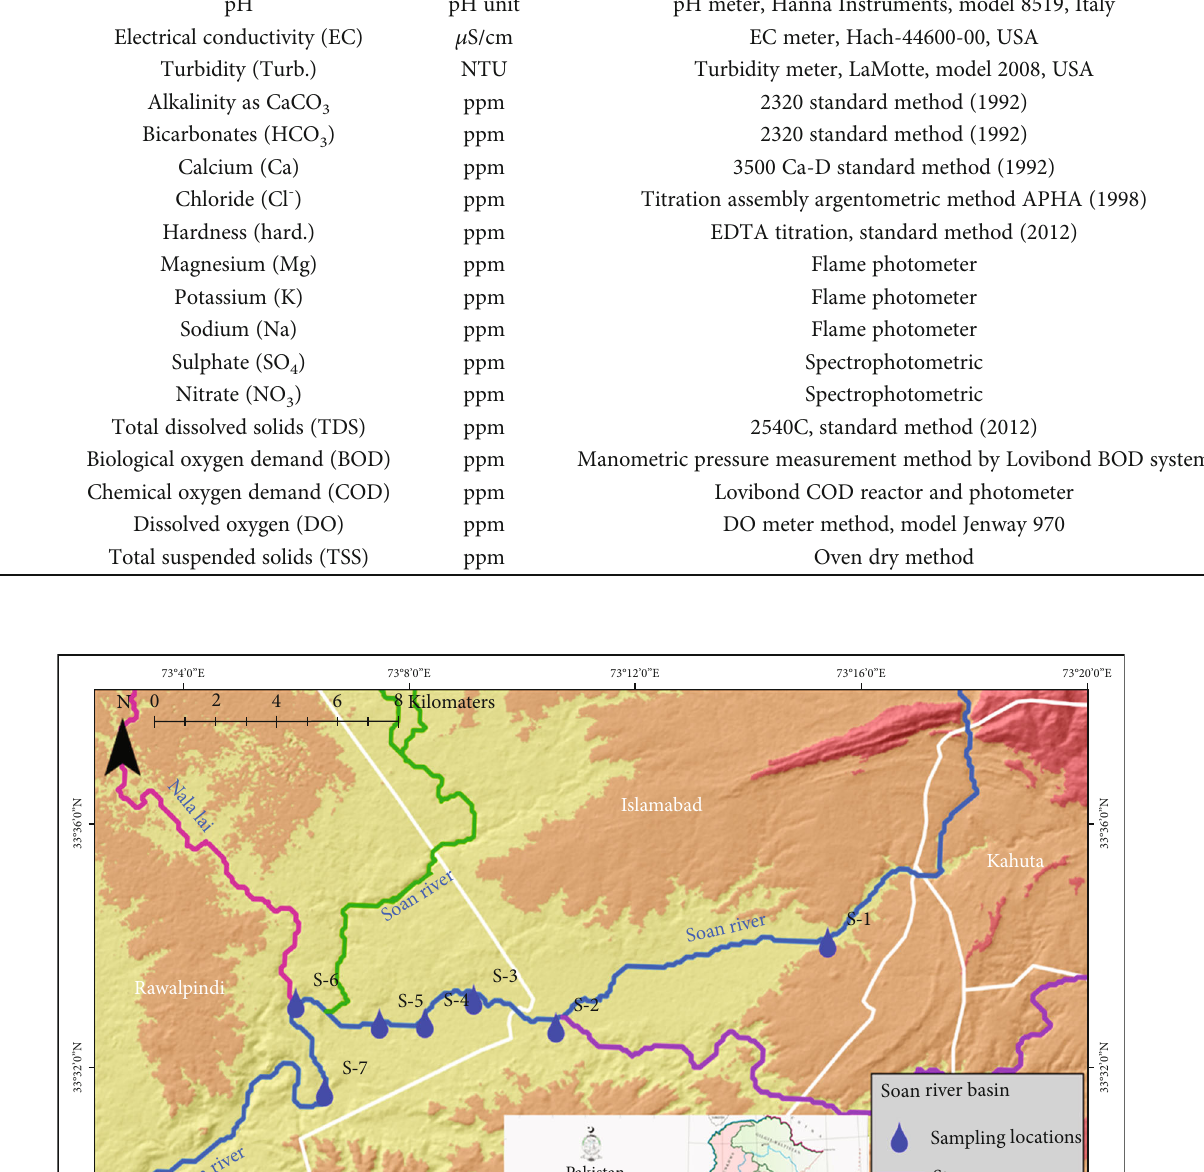
Table 1: Water quality parameters, abbreviations, units, and analytical methods used for analysis. Sr. no.